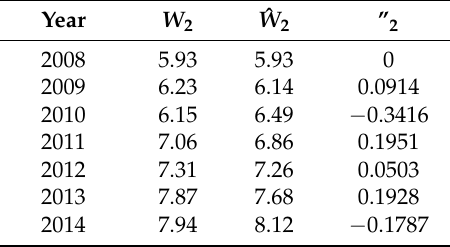
Table 4. Simulation results of W 2 .